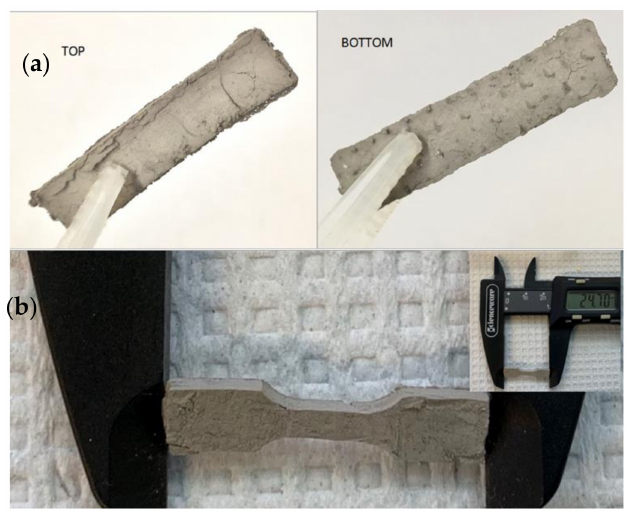
Figure 3. ( a ) The rectangular bodies were shaped by hand with a small spatula. After initial firing they were roughly the same shape as original, but clearly show imperfections. From the TOP it is apparent the body is smooth, with some thin layer formation extending past the main body edges. The BOTTOM view shows ‘dimples’ formed directly above pin holes in the underlying Grafoil. ( b ) Precursor mix (1:1 Ni:NiO) was compressed in a mold created by a 3-D plastics printer. The mold was carefully removed prior to firing. In this example two firings were conducted to ensure full reduction. It is also notable that the final shape (~25 mm long) contains surface imperfections, but the overall shape is faithful to the mold.